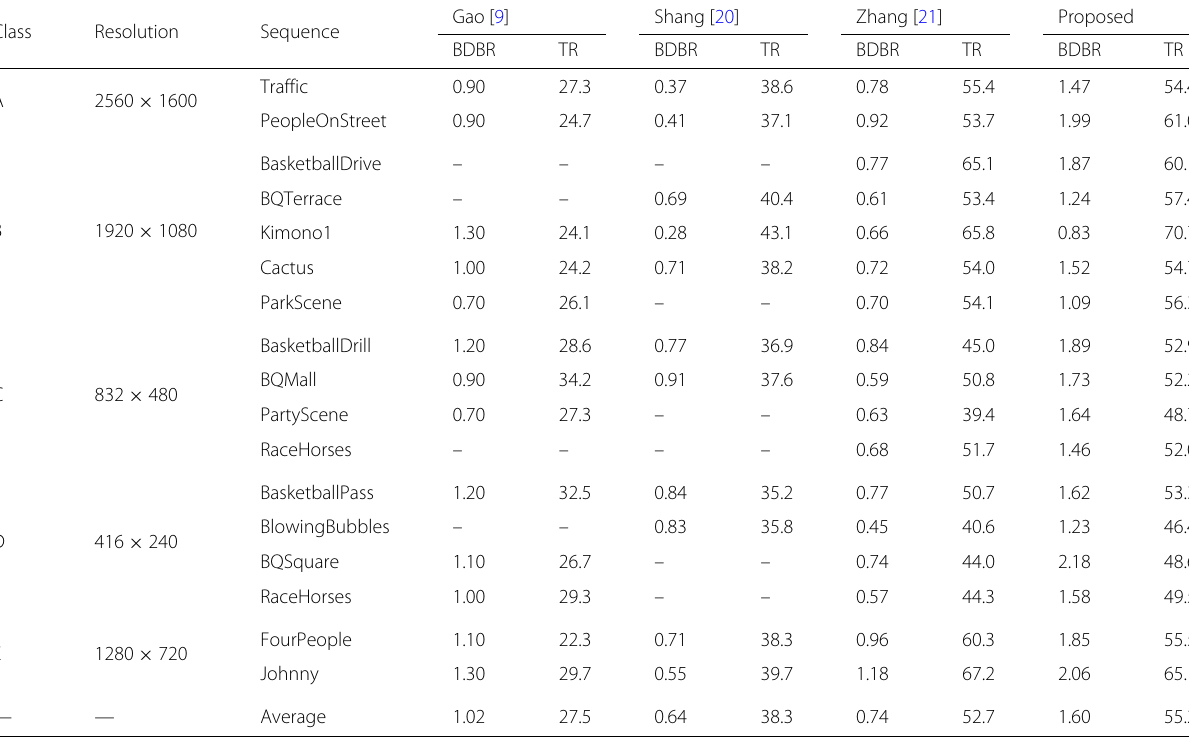
Table 5 Comparison of the proposed hybrid algorithm against the existing algorithms and HM